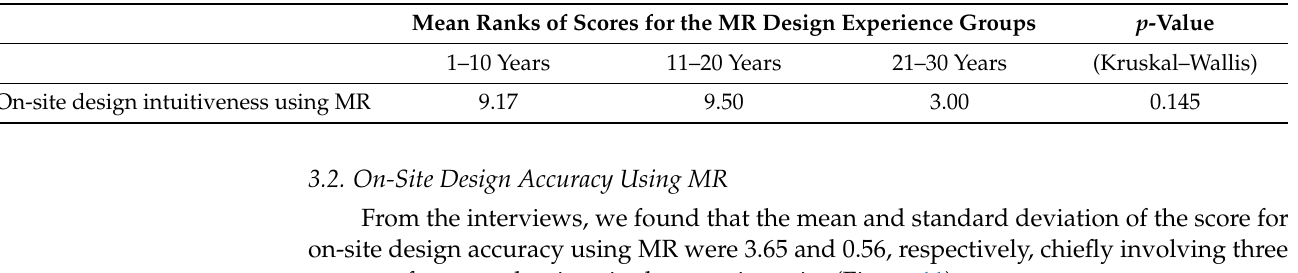
Table 1. The Kruskal–Wallis test for different MR usage experience groups in on-site design intuitiveness using MR. Mean Ranks of Scores for the MR Usage Experience p -Value Groups